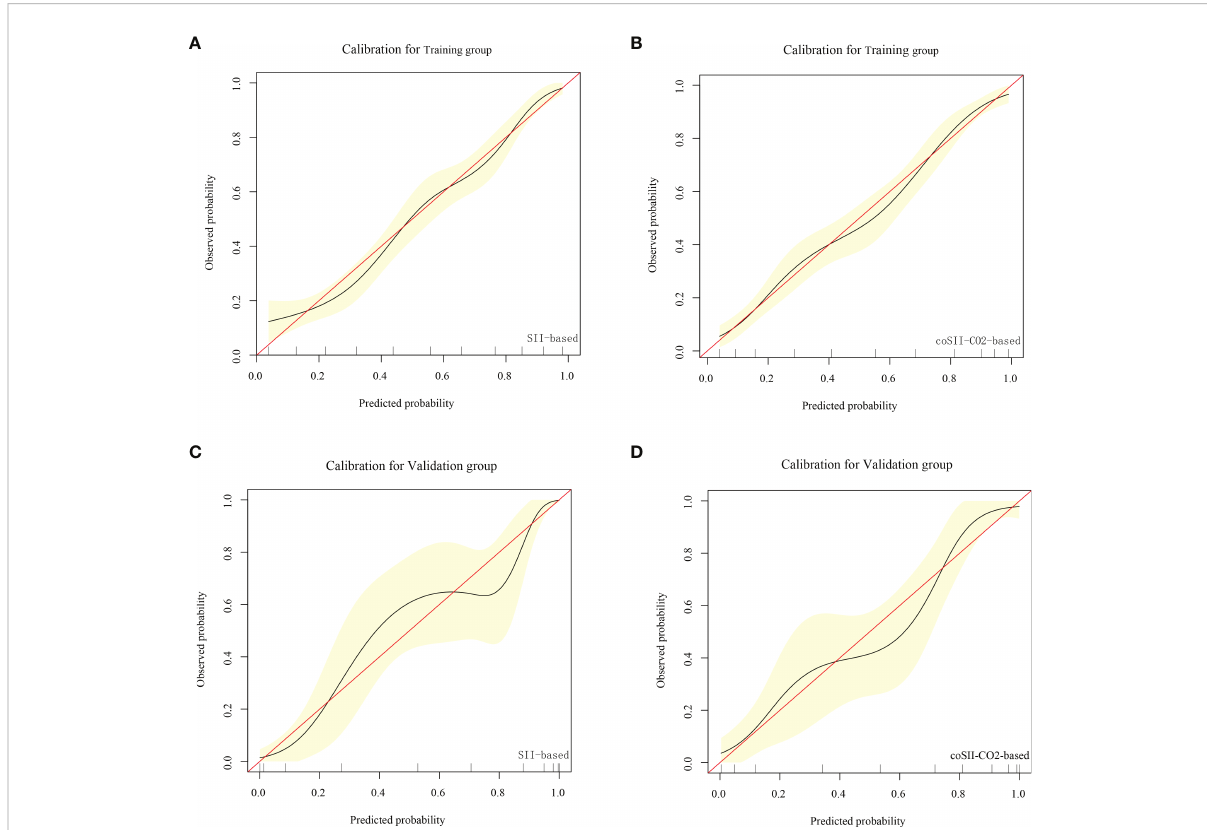
FIGURE 7 Calibration curve based on SII and coSII-CO 2 in the training and validation groups. (A, B) Clinical calibration curve analysis of the training group. (C, D) Clinical calibration curve analysis of the validation group.